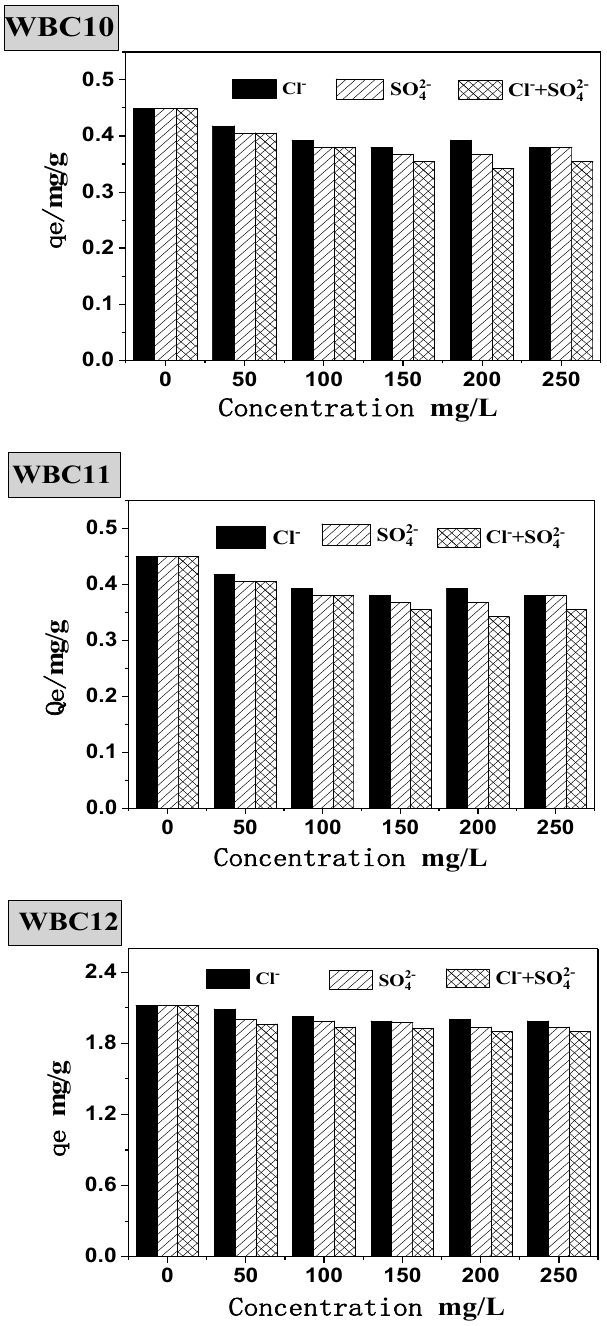
Figure 9. E ff ect of coexisting anions on phosphate Figure 9. Effect of coexisting anions on phosphate adsorption.